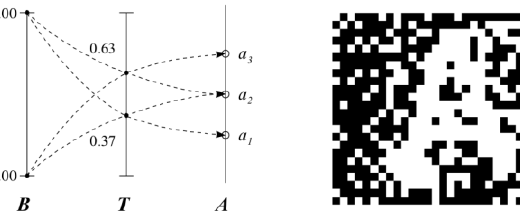
Figure 6. Partial ambiguity. Left: diagram of rule set f 3 , with arrows linking the intensities that are used. Middle, left and right: the randomly distorted bias and trigger images from an image sequence generated by rule set f 3 . Right: the target afterimage pattern, with a 1 , a 2 and a 3 shown as increasingly bright greys.